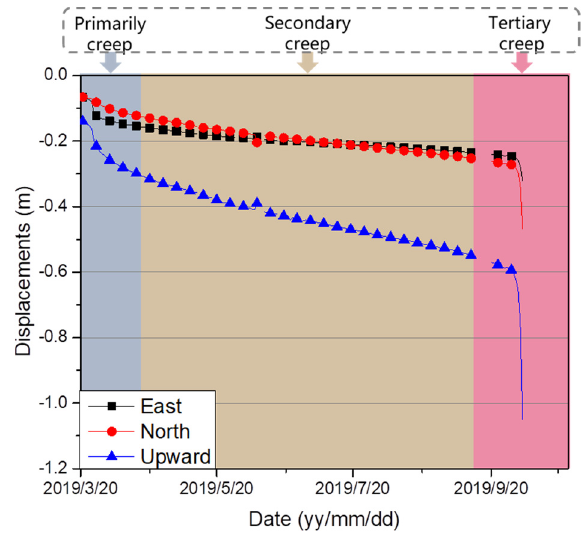
Figure1. Conventionalthree-stateinterpretationoflandslidecreepbehaviormonitoredattheHeifangtai Figure 1. Conventional three-state interpretation of landslide creep behavior monitored at the Heifangtai landslide.